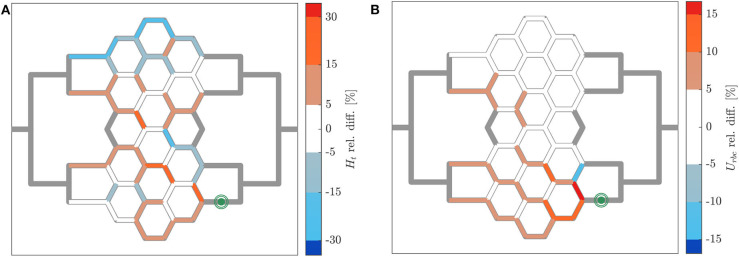
Hematocrit and RBC velocity relative difference for pericyte activation. Relative hematocrit (A) and RBC velocity (B) difference for individual micro-channels of the honeycomb network between the inflation of the pressure chamber (ΔP = 9.8 mbar, p = 2.25 bar) and the control case (ΔP = 9.8 mbar, p = 0 bar). The green symbol indicates the activated micro-channel. Flow direction is from left to right.